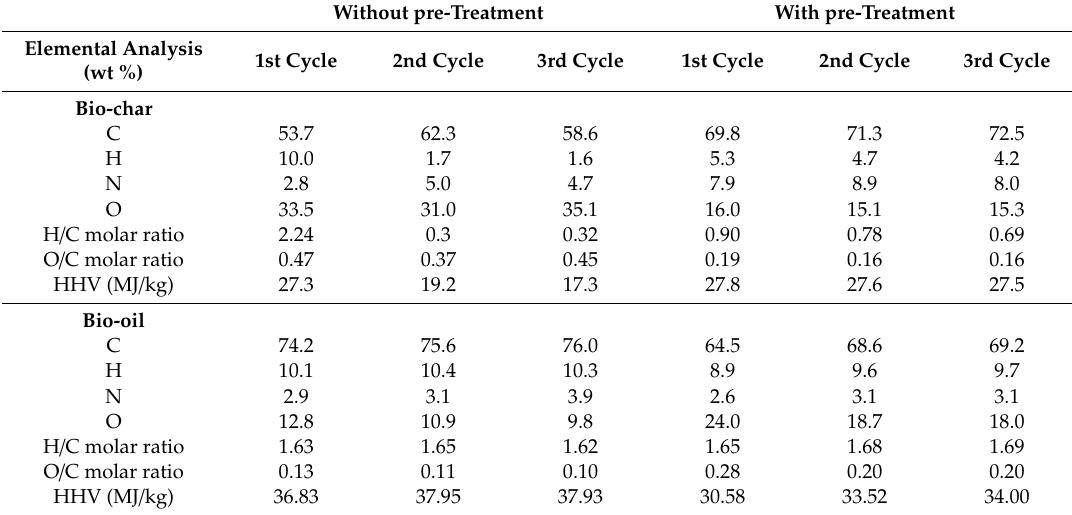
bio-oils obtained from treated and non-treated microalgae